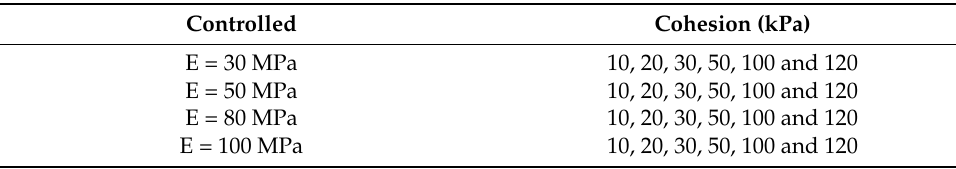
Table 7. Controlled parameters and varying parameters.